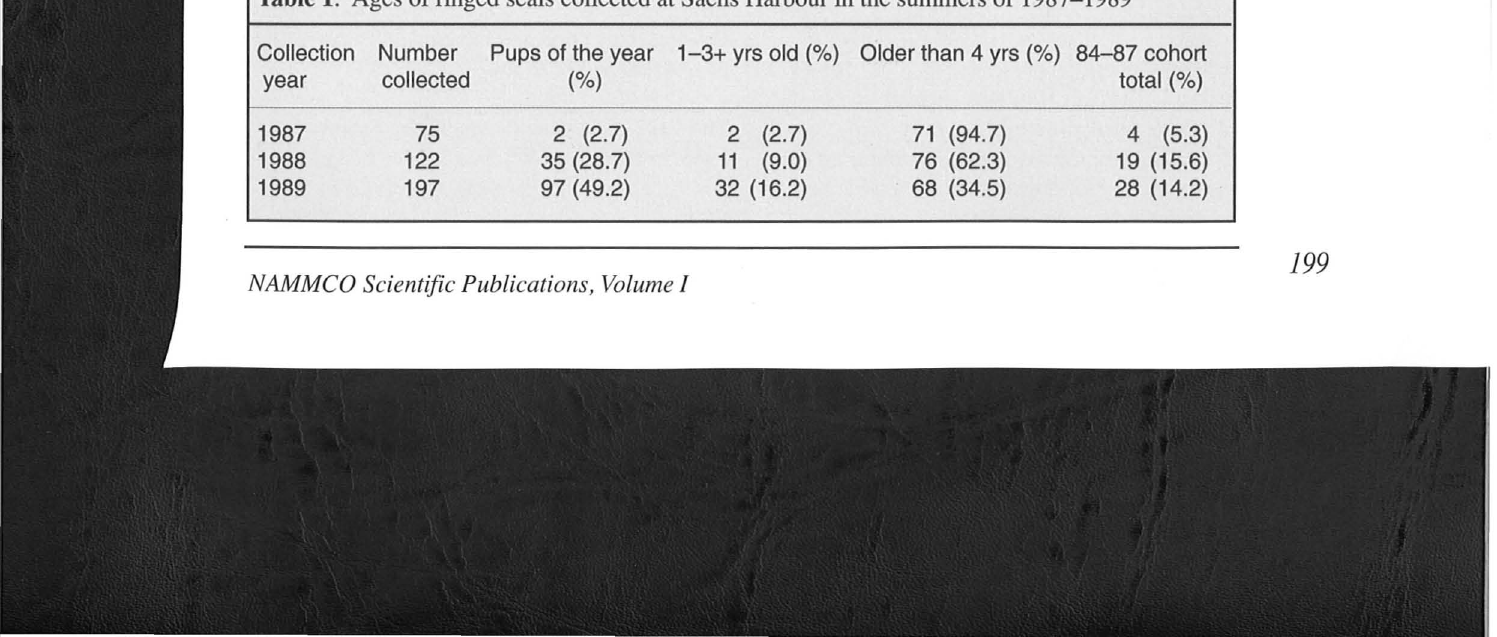
Table 1. Ages of ringed seals collected at Sachs Harbour in the summers of 1987-1989 Collection